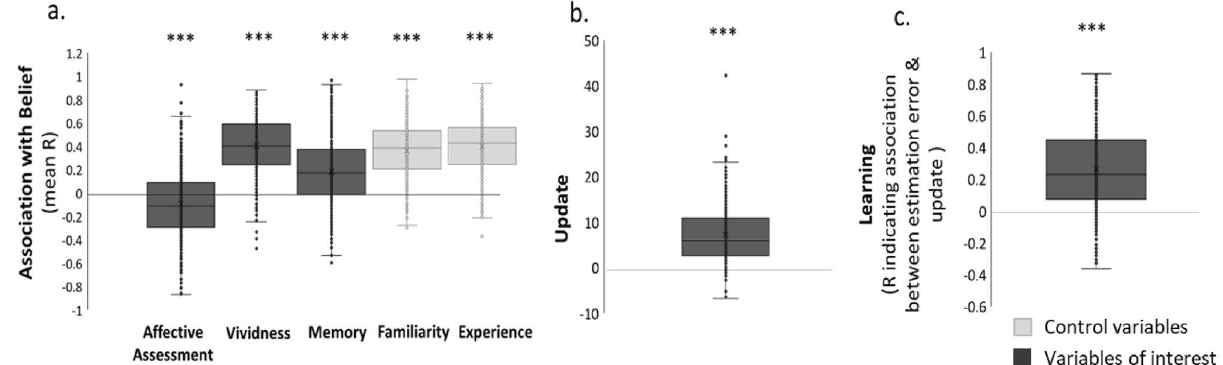
Figure 2. Beliefs are associated with vividness of imagination, affective assessment, learning and memory. ( a ) Plotted are the mean correlation coefficients obtained by correlating for each participant across trials their prior belief (first estimate) with each rating. Results show that participants believed they were more likely to encounter an aversive event when they imagined the event more vividly, less negatively, and also when they were more familiar with the event, and had experienced it in the past. Participants also tended to remember the likelihood presented to them as greater when their prior regarding that likelihood was greater. ( b ) Average update scores (calculated as the difference between the first and second estimate coded positively when update is towards the information and negatively otherwise) were significantly greater than zero, suggesting that beliefs are modulated in response to new information. ( c ) Learning scores (the correlation between update and estimation errors) are significantly greater from 0, indicating that subjects were learning. Horizontal lines indicate median values, boxes indicate 25–75% interquartile range, the crosses indicate mean values and whiskers indicate 1.5 × interquartile range; individual scores are shown separately as circles.*** p < 0.001. In black are variables of interest for heritability